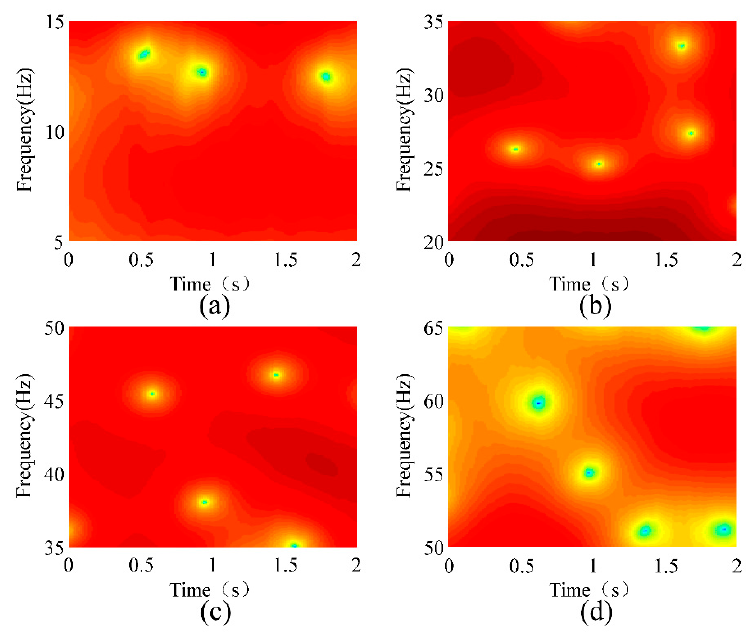
Figure 14. STFT analysis of the conductor’s vibration responses at a wind velocity of 3.7 m/s. ( a ) 1st Mode; ( b ) 2nd Mode; ( c ) 3rd Mode; ( d ) 4th Mode.